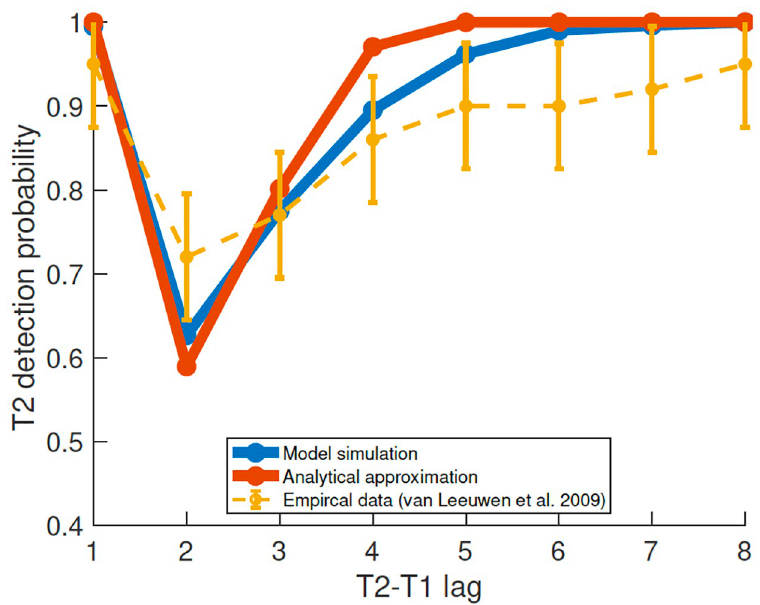
Fig 2. The attentional blink effect, model and typical data. T2 detection probability for different T1-T2 lags. Typical empirical data, replotted from [4] (yellow). Model simulated detection probability averaged over N = 1, 000 repetitions (blue). An analytical calculation of the probability, using double exponential distribution was used to approximate the distribution of the maximal attentional load (red).